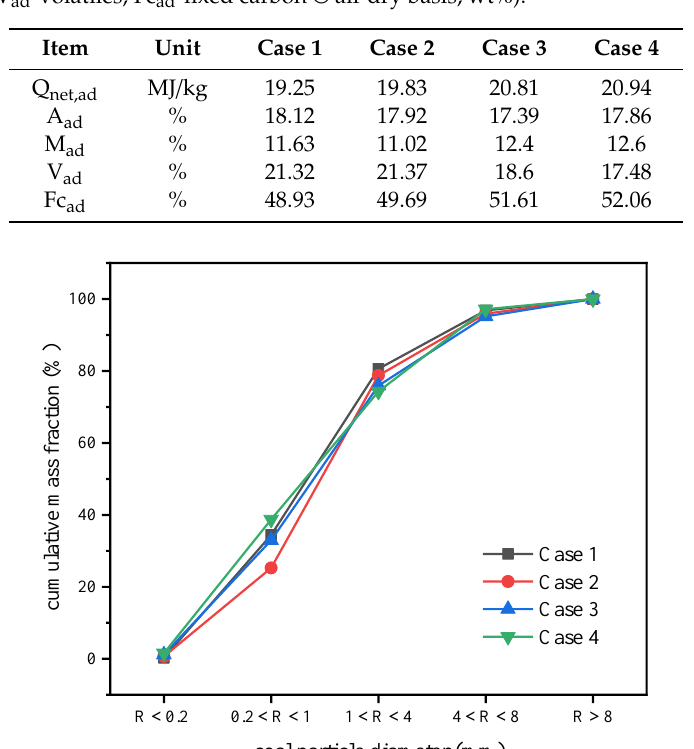
Table 3. Proximate analysis of the feeding coal under various working conditions (A ad -ash; M ad -